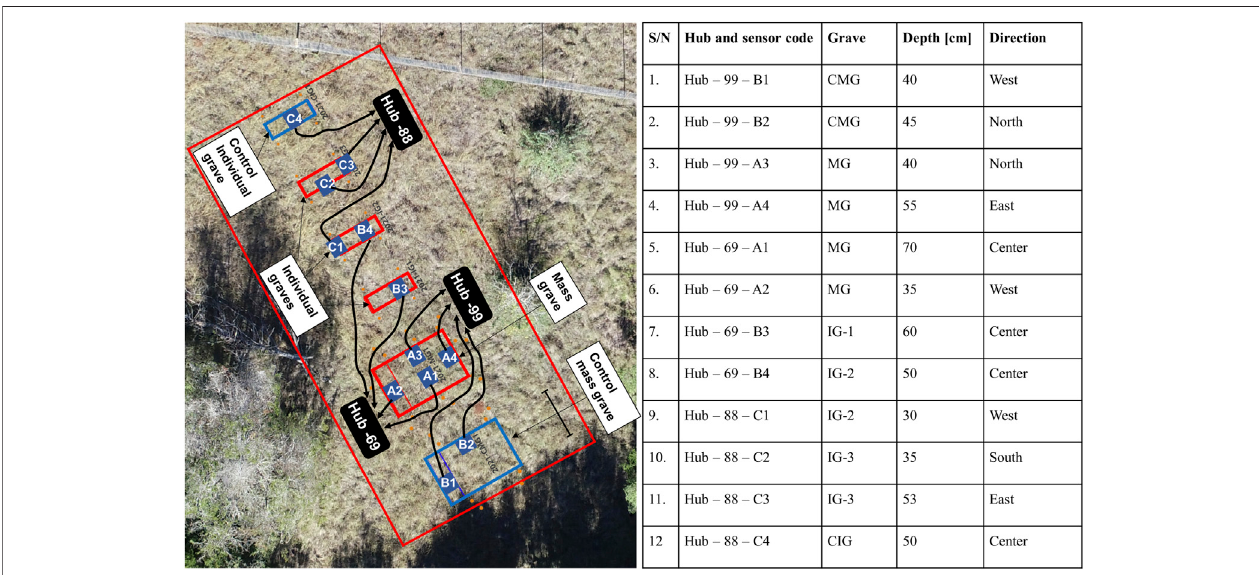
FIGURE 3 | Outline of the graves and location of each of the soil sensors. Both position and installation depth of each sensor is presented in a tabular form on the right.